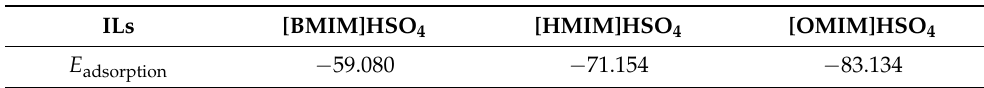
Figure 6. The stable adsorption configurations of [BMIM]HSO 4 , [HMIM]HSO 4 , and [OMIM]HSO 4 on the Cu(111) surface in sulfuric acid from the MD simulations ( above : front view, below : top view). Table 4. Adsorption energies of three ILs inhibitors in sulfuric acid solution from an MD simulation